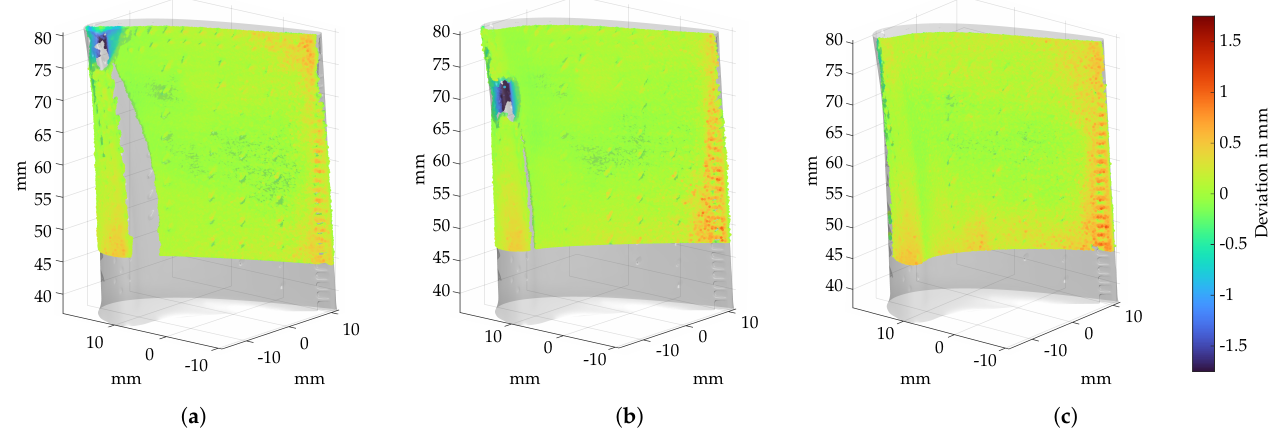
Figure 11. Deviation analysis using the example of 3 turbine blades, where the point deviation is calculated to a reference geometry of an healthy blade. ( a ) Point deviation of turbine blade 2. ( b ) Point deviation of turbine blade 4. ( c ) Point deviation of turbine blade